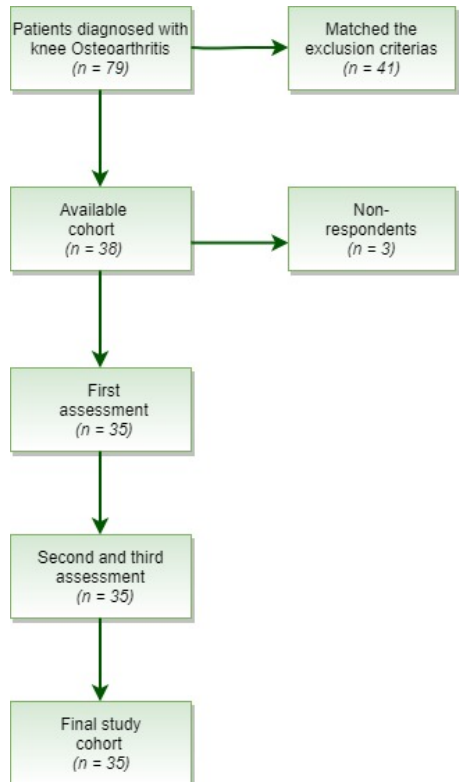
Figure 1. Flow diagram of patient cohort.